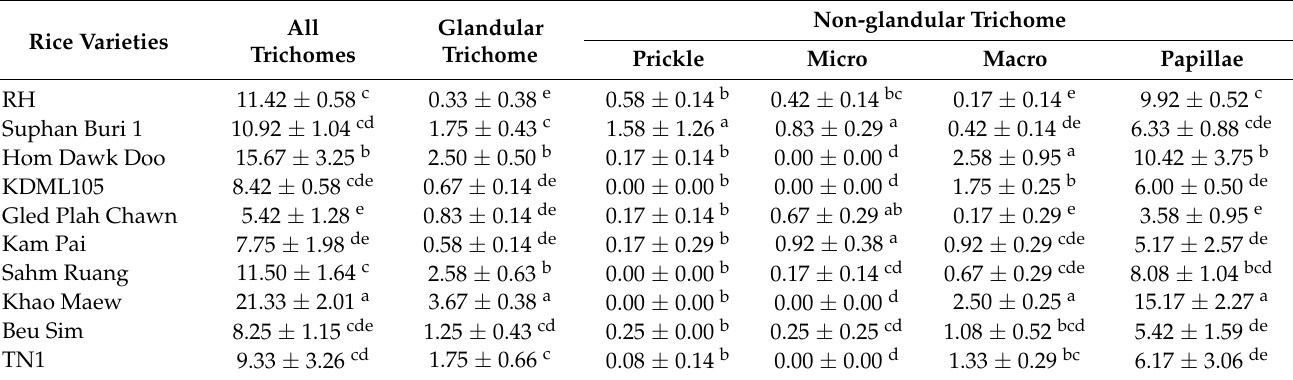
Table 4. Density of trichomes on the leaf surface of 10 rice varieties.